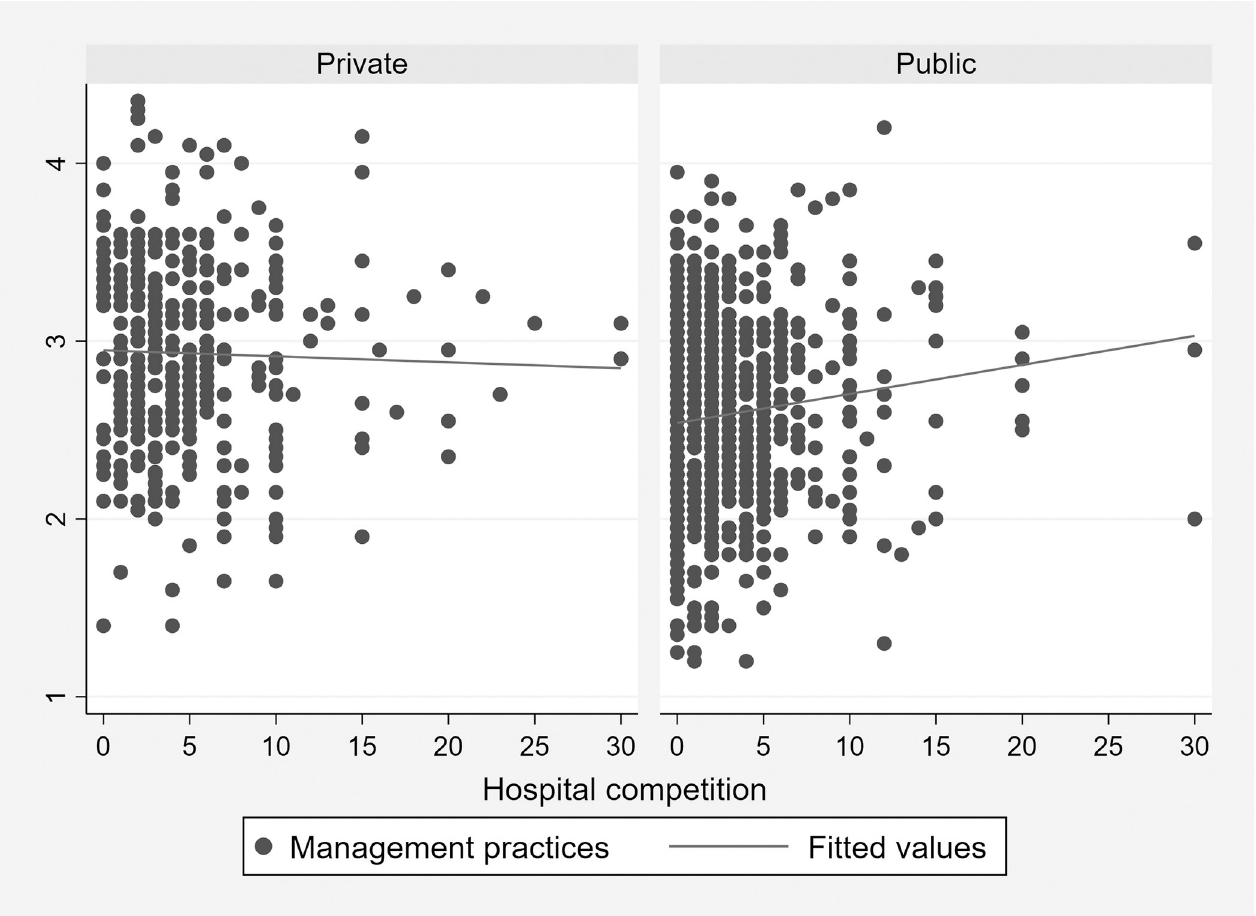
Fig 4. Management practices and hospital competition, public and private. Source: World Management Survey (Hospitals sub-sample).